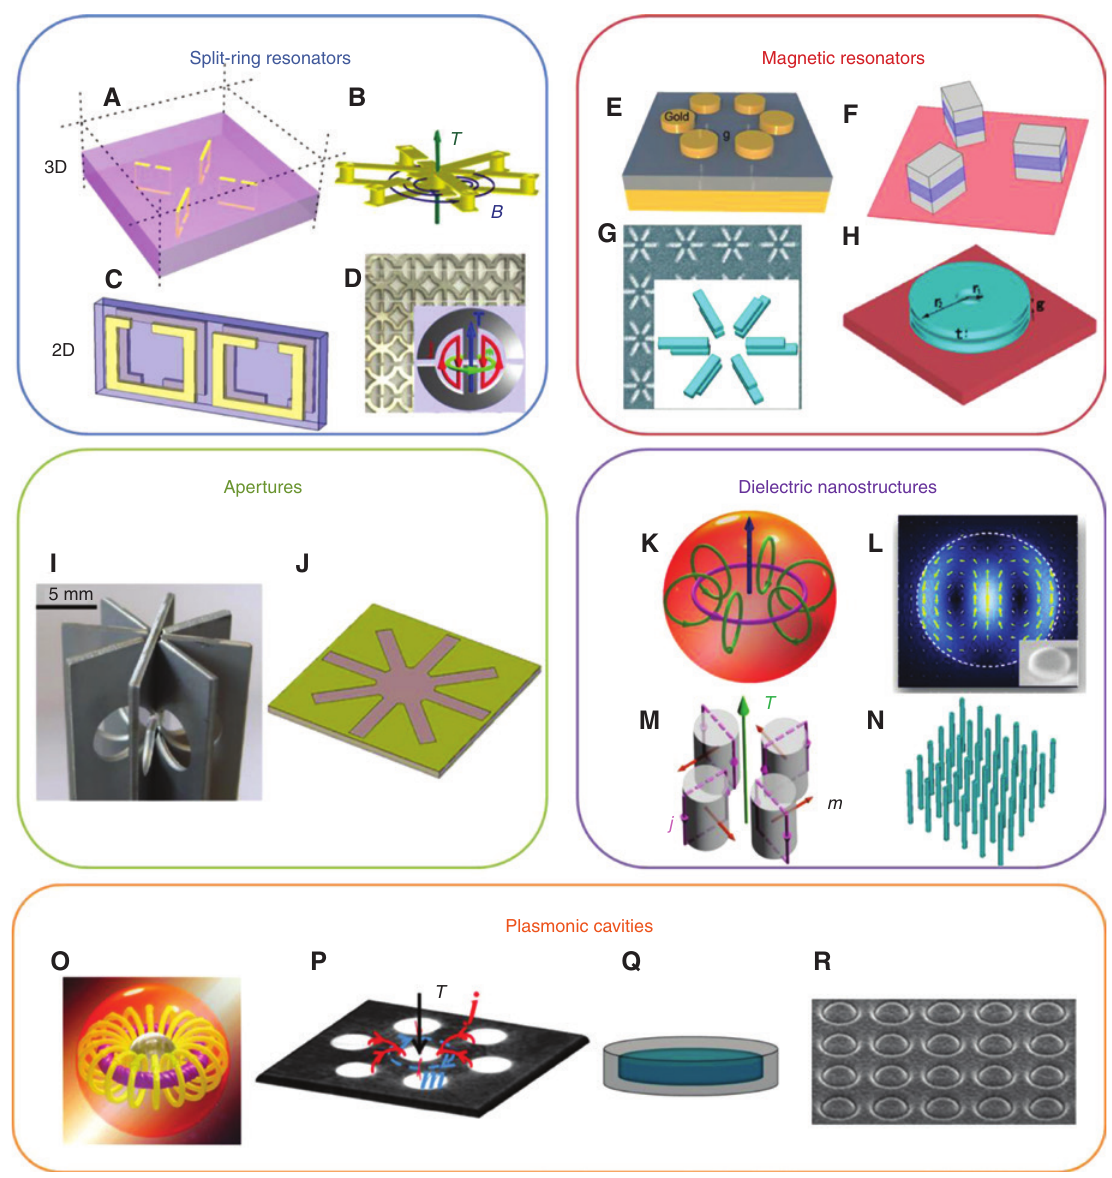
Figure 4: A brief overview of the investigated metamolecules with toroidal dipolar responses. Split-ring resonators (SRR): (A) Schematic drawing of 3D SRR constituted by four rectangular metallic wire loops embedded in a